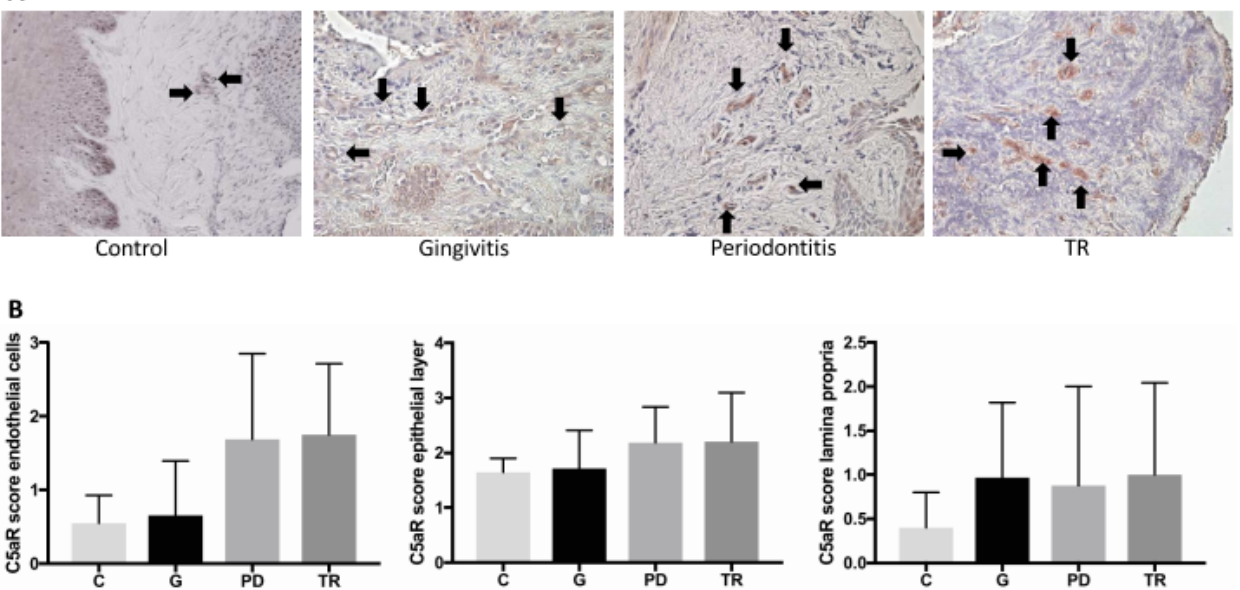
Figure 4. ( A ) Immunohistochemical staining of the complement C5a receptor (C5aR). Images were taken at 400 × magni- fication. The endothelial layer of the vessels in the gingiva of the controls (C) ( n = 4) and cats affected by gingivitis (G) ( n = 6), periodontitis (PD) ( n = 7) or tooth resorption (TR) ( n = 12) is marked by black arrows. In the controls and gingivitis animals, only a few endothelial layers were stained. The staining in general was less marked than in in the other two groups (PD, TR). ( B ) No significant differences were observed between the groups. However, there was a trend for a difference in periodontitis and TR compared to control and gingivitis regarding the endothelial layer. In addition, there was a trend for a difference in positively stained cells of the lamina propria between the control group and the other groups.